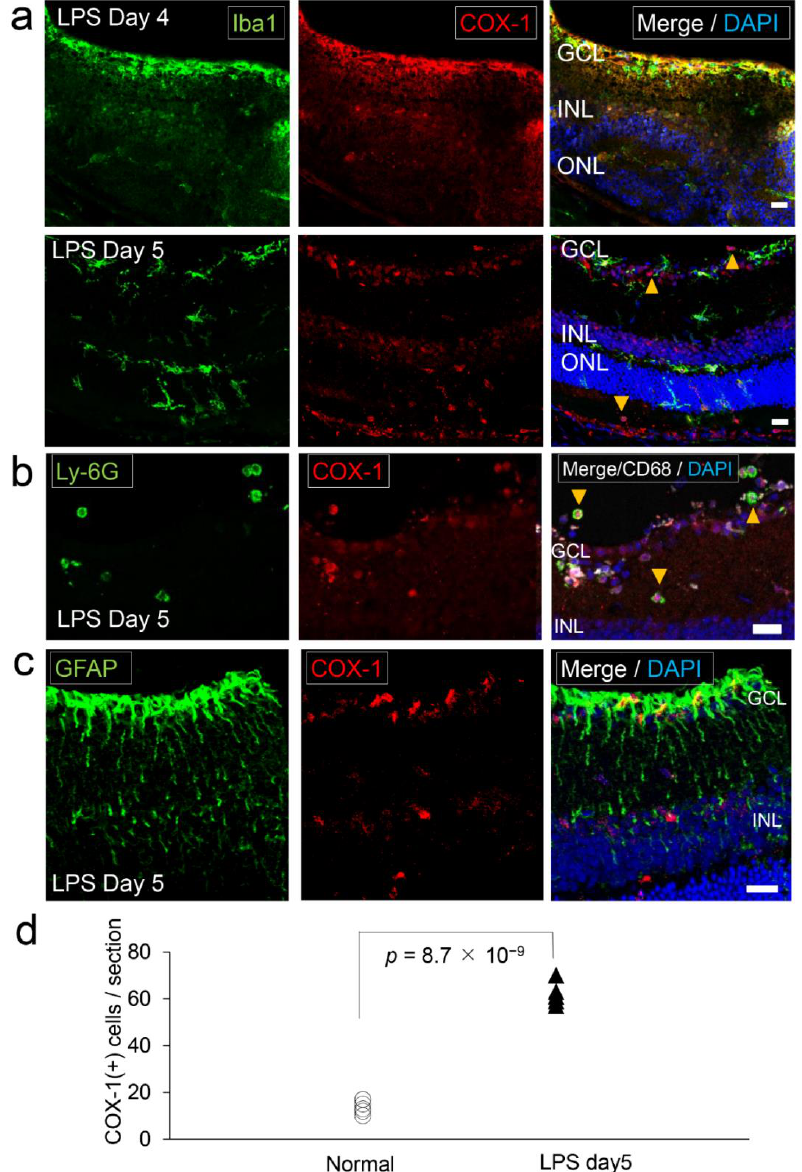
Figure 6. COX-1 + microglia/macrophage and neutrophils in the lipopolysaccharide (LPS)-treated ocular inflammation model. LPS was administered into the vitreous cavity of the mice to induce ocular inflammation. Photomicrographs show the retina in LPS-administrated model mice. ( a ) Retinal section labeled with Iba1 (left) and COX-1 (middle). On day four after LPS-administration (LPS day four), COX-1 + cells accumulated in the inner layer of the retina near the GCL, most of which coincided with Iba1 + staining. On day five, COX-1 + cells were present throughout the whole retina, and some COX- 1 + cells did not coincide with Iba1 + staining (yellow arrowheads). Iba1 + cells had amoeboid morphology. Scale bar, 20μm. ( b ) Retinal section (LPS day five) labeled with Ly-6G (neutrophil marker; left) and COX-1 (middle). There were infiltrating Ly-6G + cells. Ly-6G + cells coincided with COX-1 + staining (yellow arrowheads). Scale bar, 20μm. ( c ) Retinal section labeled with GFAP (left) and COX-1 (middle). GFAP immunopositivity was stronger than normal retina (also see Figure 1d), but did not colocalize with COX-1. Scale bar, 20 μm. ( d ) A graph showing the number of COX-1 + cells in a retinal section of LPS-treated ocular inflammation model and normal mice ( n = 5). COX-1 + cells include both Iba1 + and Iba1 – cells. COX-1 + cells were significantly increased in the retina of the LPS-treated ocular inflammation model.